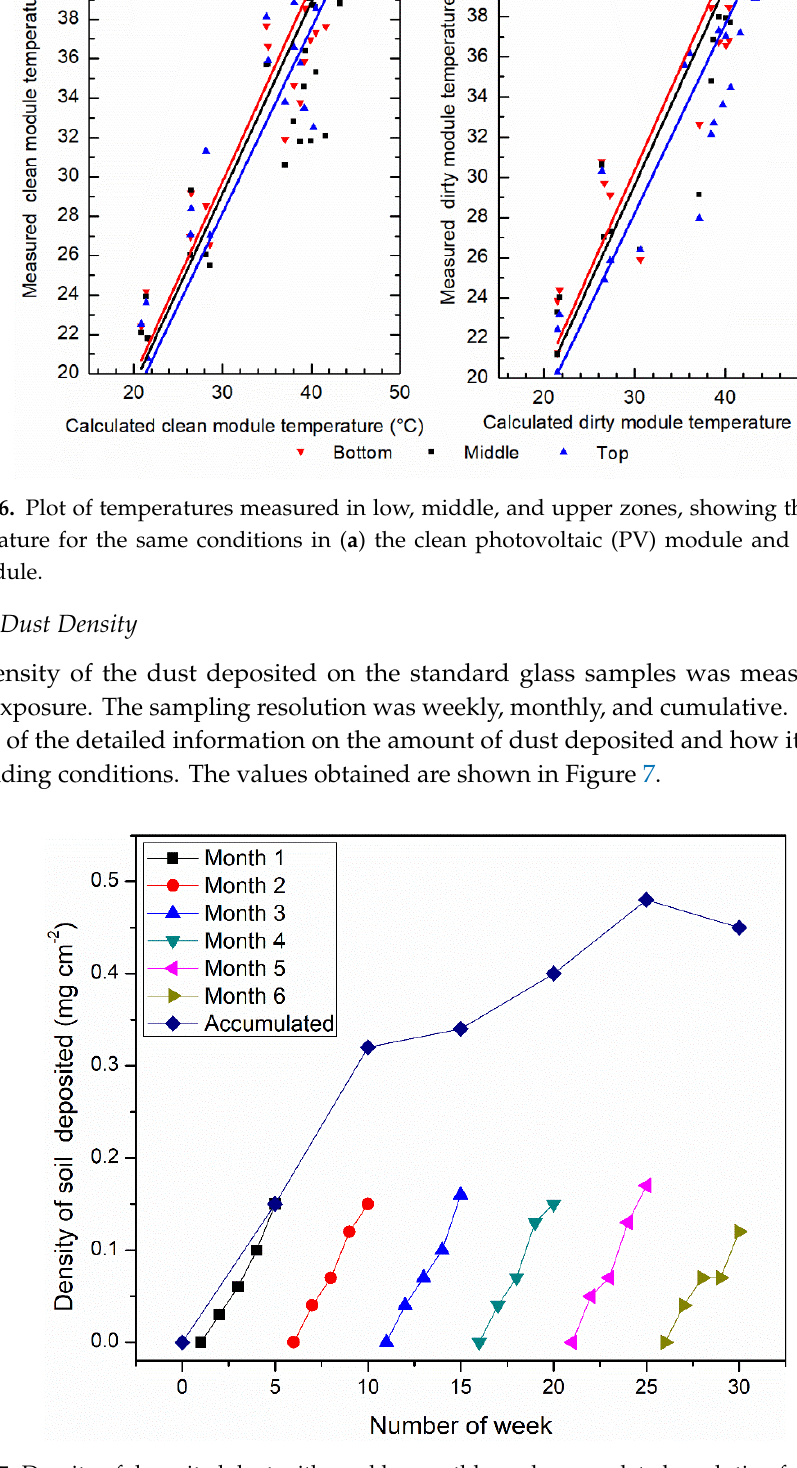
Figure 7. Density of deposited dust with weekly, monthly, and accumulated resolution for six months.